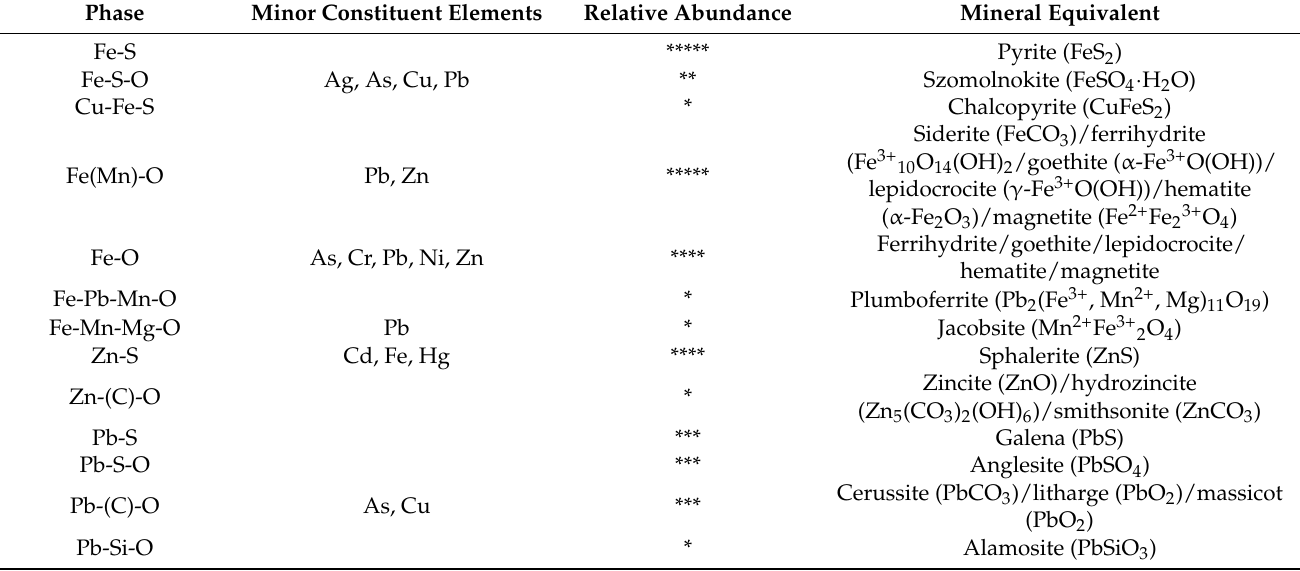
Table 1. Solid PTE carriers identified with SEM/EDS in stream sediments and mine waste material with common minor constituent elements, their relative abundance, and possible mineral